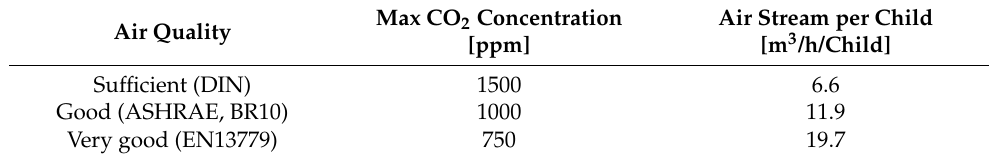
Table 6. Air stream assuring good air quality.